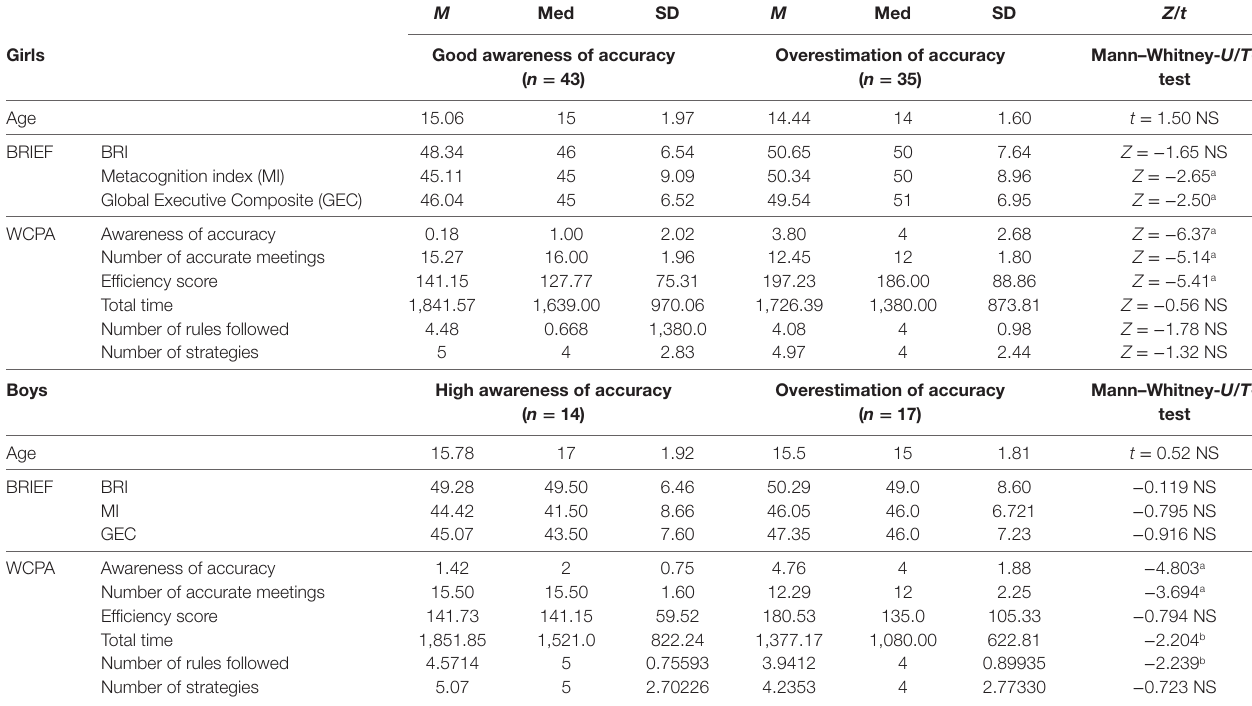
TaBle 3 | Comparison of weekly calendar planning activity (WCPA) and BRIEF scores between groups with high and low awareness. M Med sD M Med sD Z /